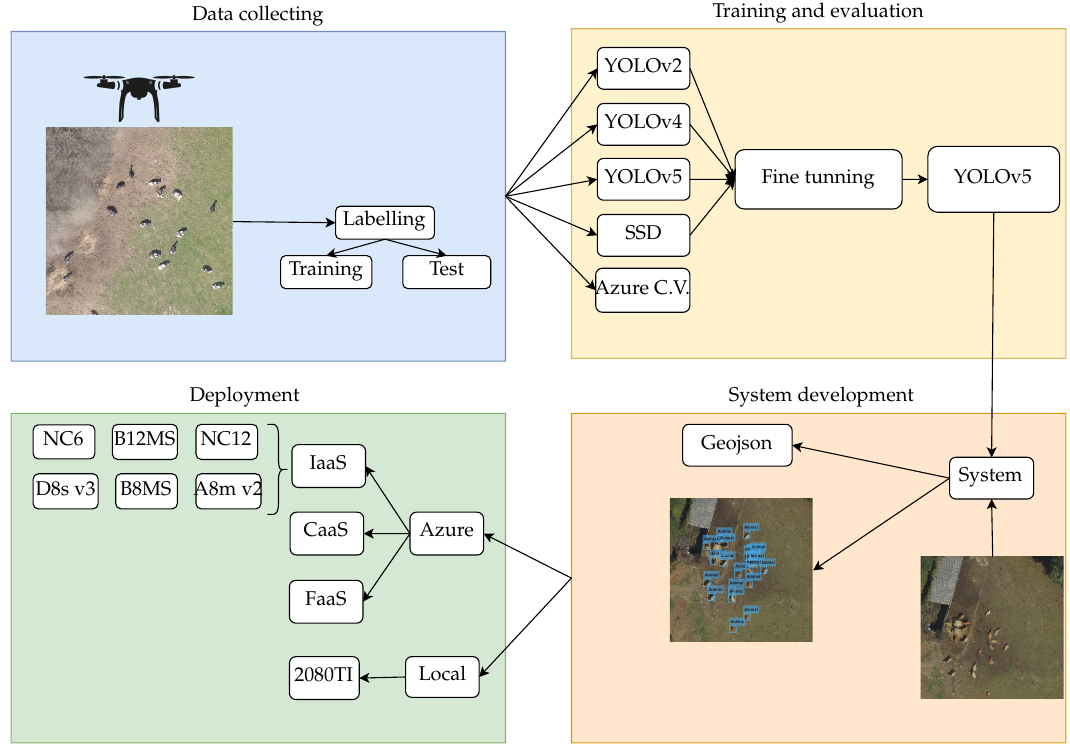
Figure 1. Workflow for the development of the livestock activity recognition